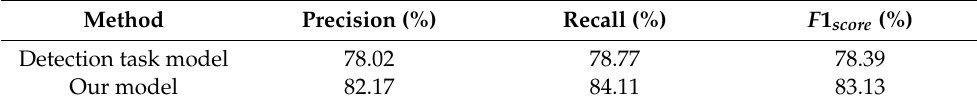
Table 10. Comparison of experimental results between the judgment task model and our model.